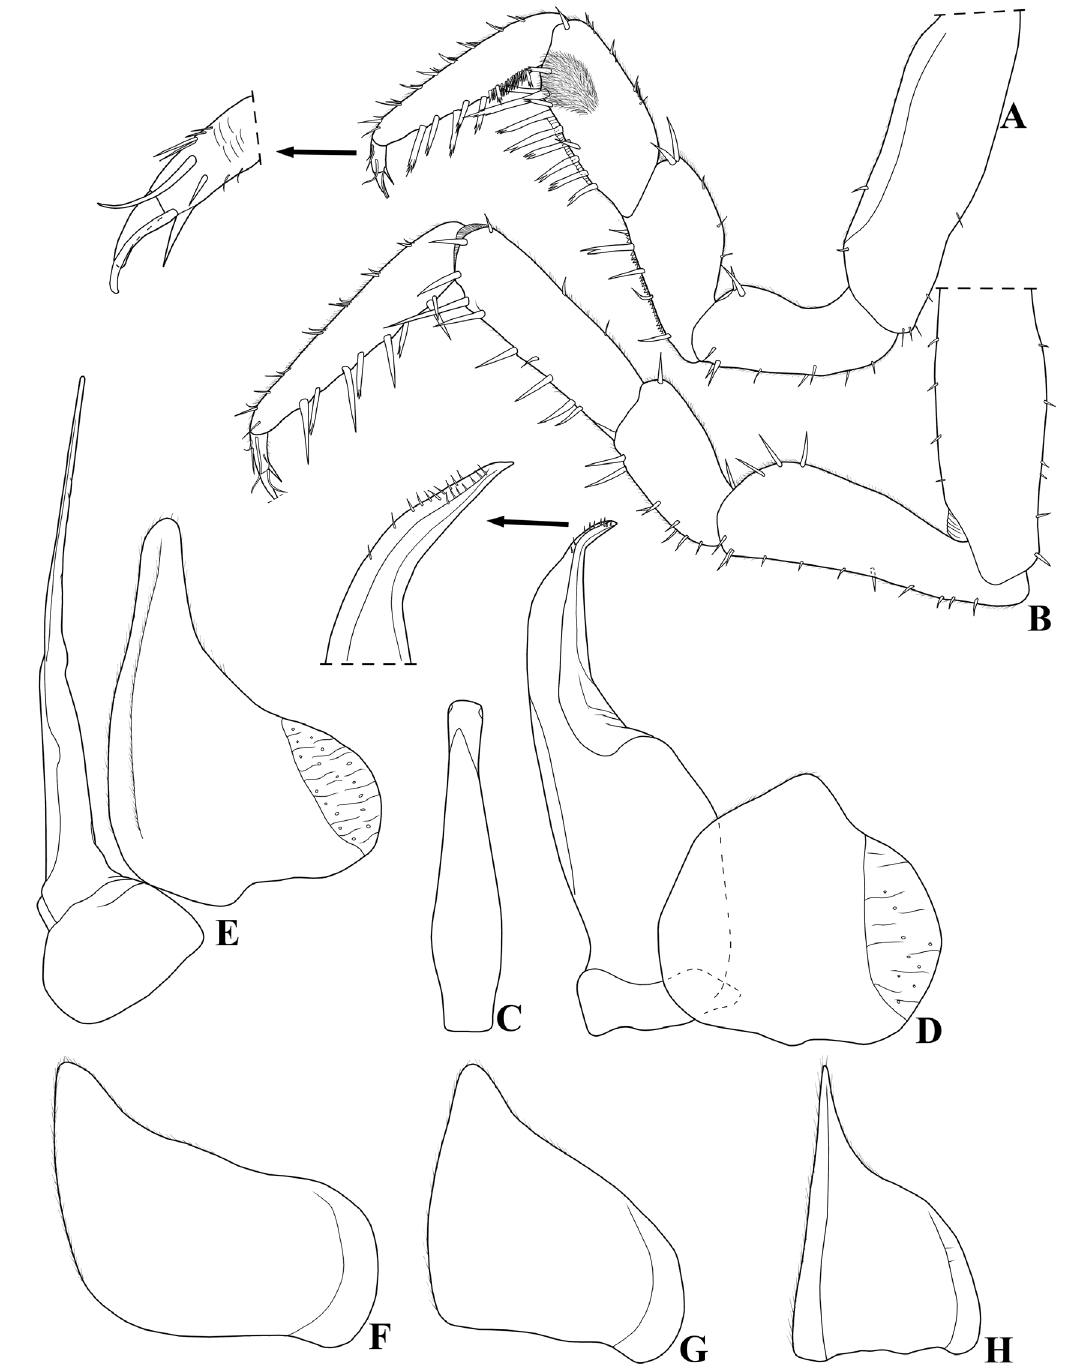
Fig. 13. Amazoniscus spica Campos-Filho, Aguiar & Taiti sp. nov., ♂, paratype (MZUSP 40047). A . Pereopod 1. B . Pereopod 7. C . Genital papilla. D . Pleopod 1. E . Pleopod 2. F . Pleopod 3 exopod. G . Pleopod 4 exopod. H . Pleopod 5